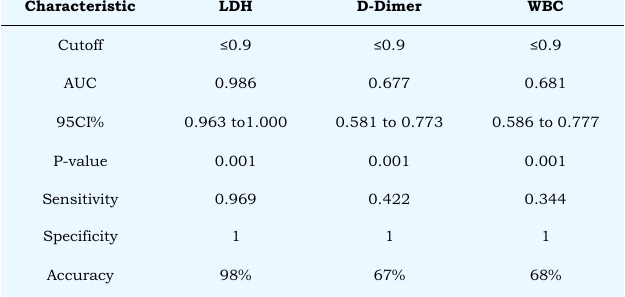
Table 5 The characteristics of receiver operator characteristics (ROC) curve analysis for WBC, D-Dimer, and LDH Characteristic